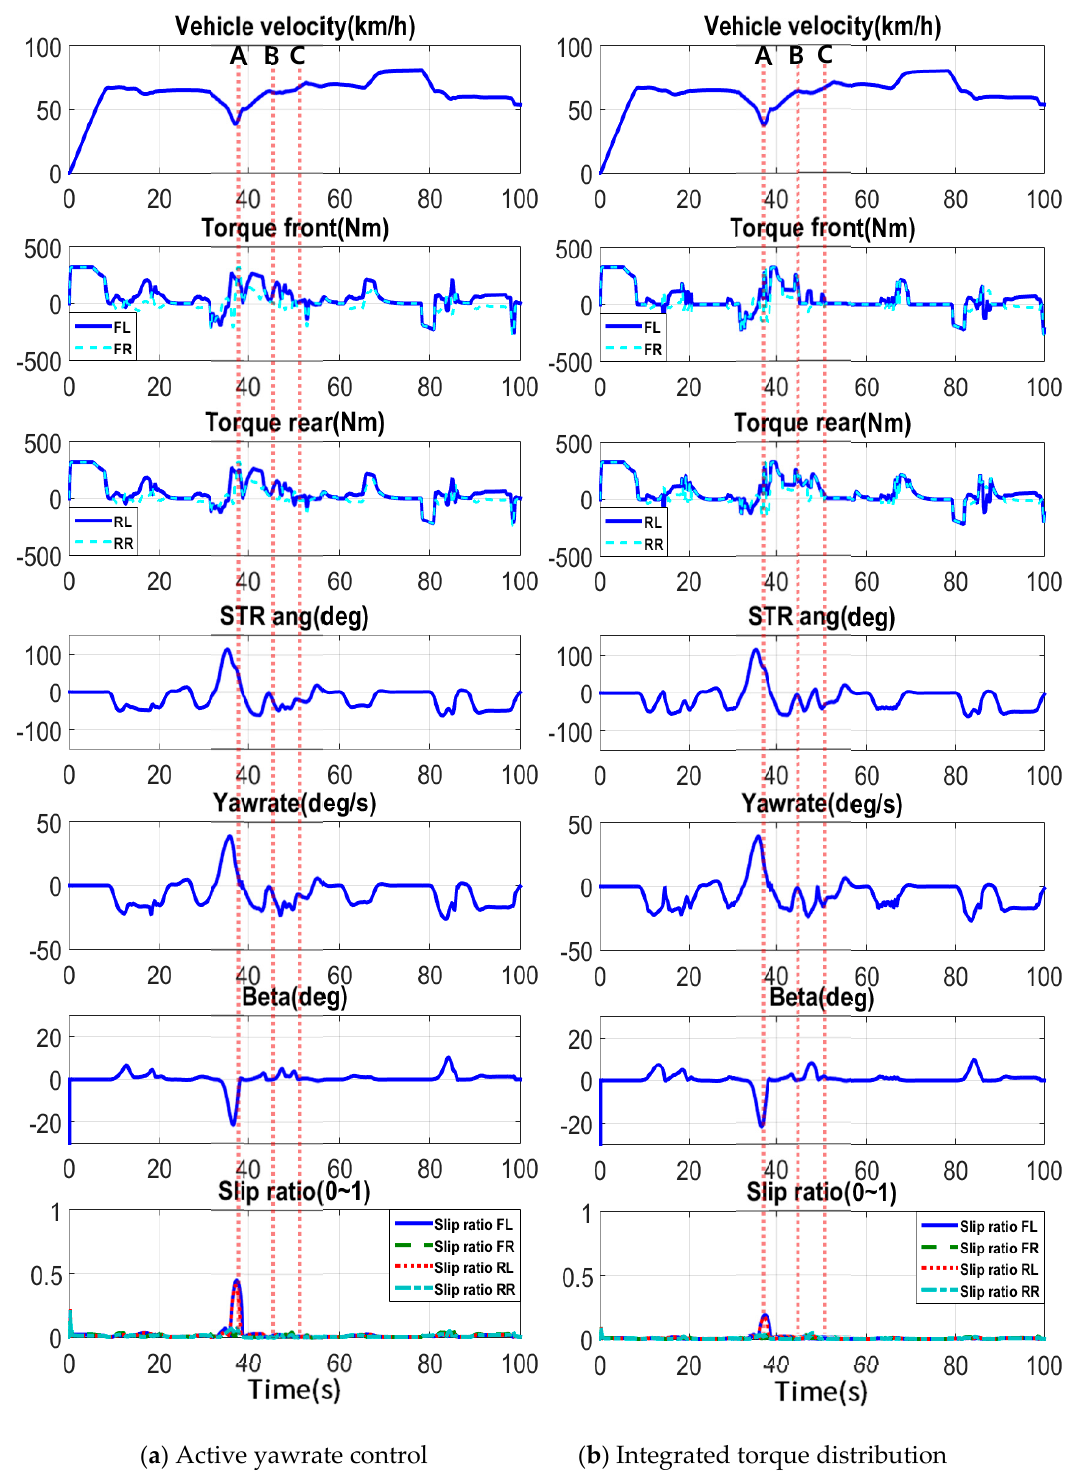
Figure 14. Simulation results for complex driving road (AYC, ITD).